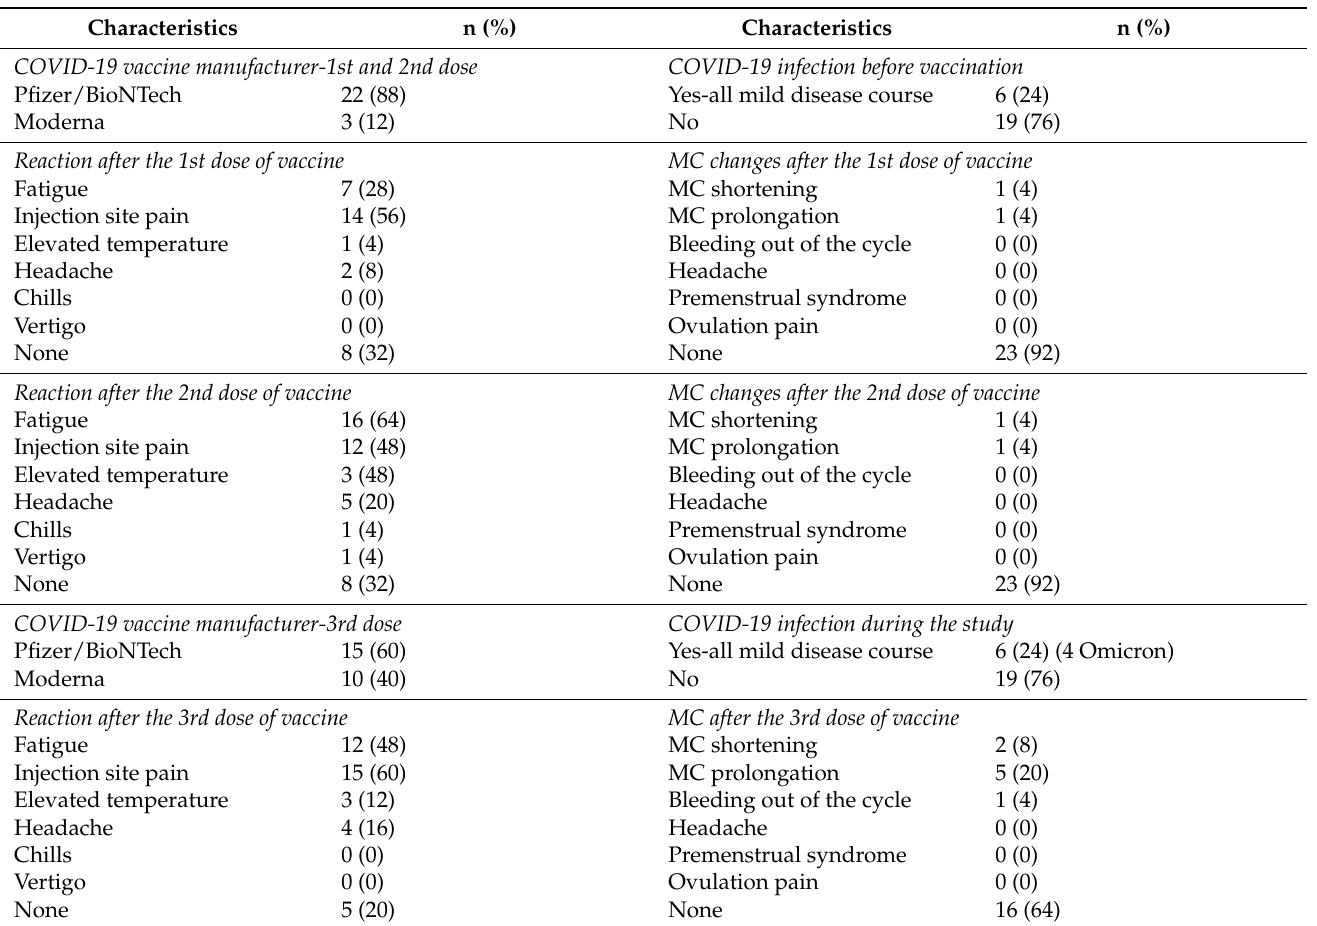
Table 1. The overall reactions and menstrual cycle changes after the first, second and third doses of COVID-19 vaccines. MC—menstrual